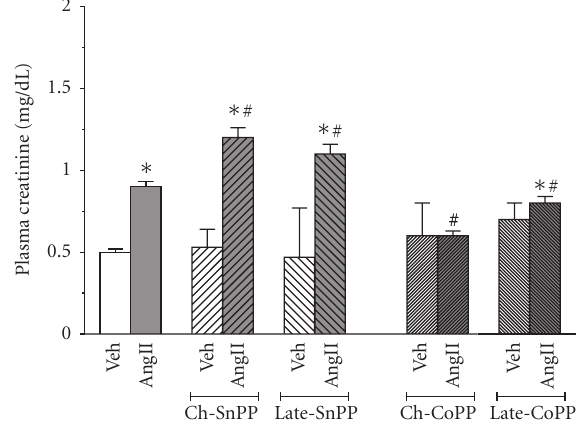
Figure 3: E ff ect of SP-Ang II and HO modulation on the plasma creatinine levels was determined in the following groups; Vehicle (Veh) treated ( n = 6), SP-AngII-treated ( n = 6), chronic-SnPP- (Ch-SnPP-) treated ( n = 6), SP-AngII/Ch-SnPP-treated ( n = 6), late SnPP-treated ( n = 5), SP-AngII/late-SnPP-treated ( n = 5), chronic-CoPP- (Ch-CoPP-) treated ( n = 6), SP-AngII/Ch-CoPP– treated ( n = 6), and late-CoPP-treated ( n = 5), SP-AngII/late CoPP-treated ( n = 6) rats. ∗ P < 0 . 05 versus. control, # P < 0 . 05 versus.